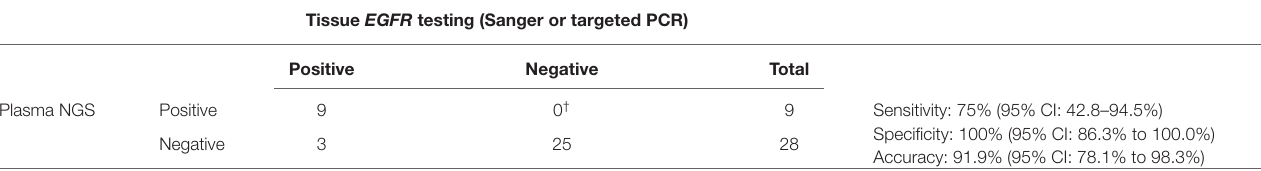
TABLE 2 | Concordance analysis of EGFR mutation detection by targeted tissue EGFR testing and plasma NGS for 37 NSCLC cases.